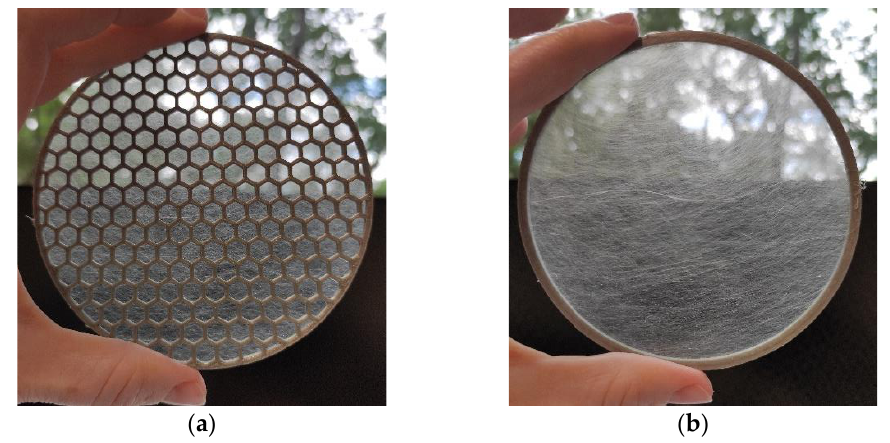
Figure 4. Images of a PA6 nanofibrous structure on: ( a ) grid M2; ( b ) grid R (ring).